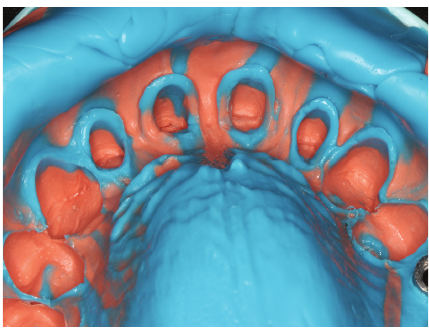
Figure 4: Definitive impression.